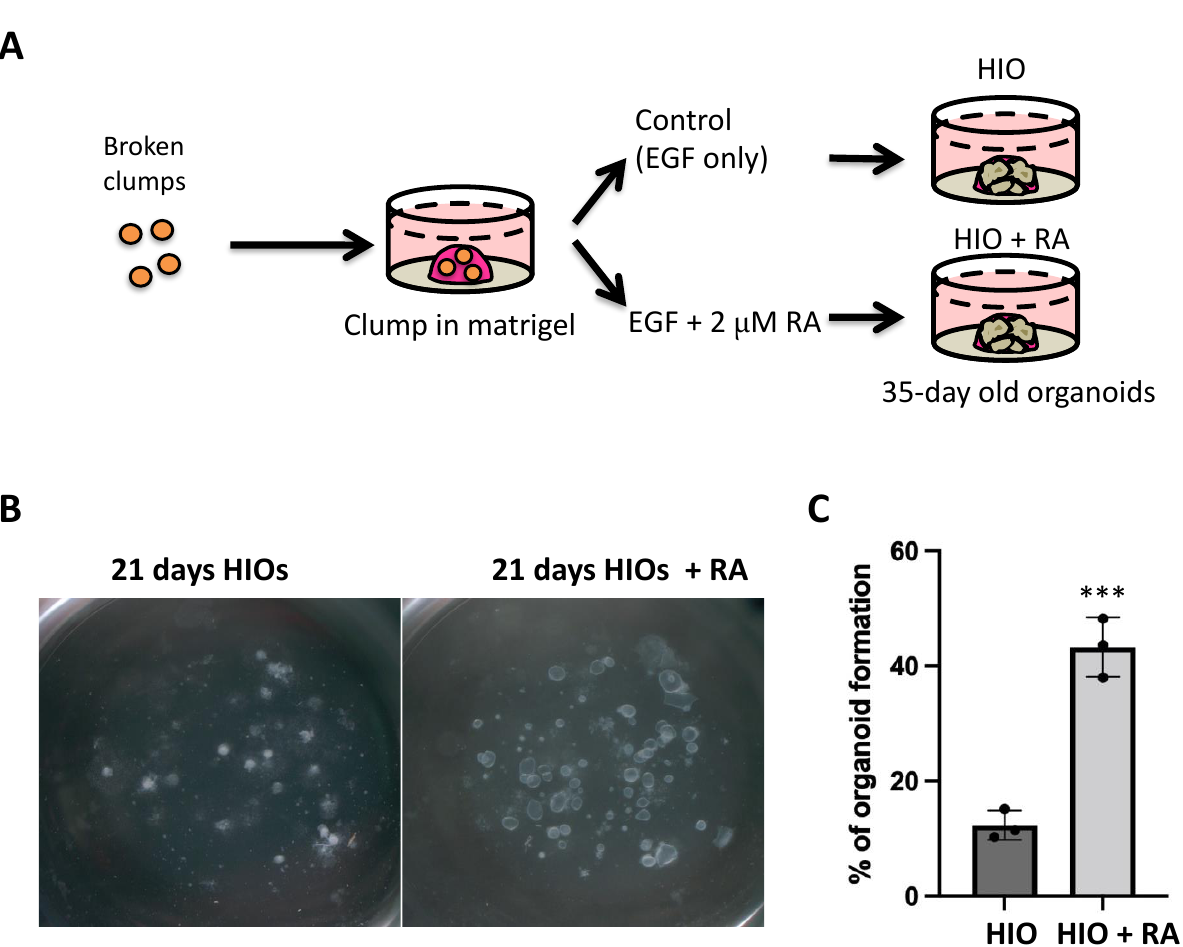
Figure 2. Retinoic acid treatment improves organoid generation. ( A ) Schematic of retinoic acid treatment experiments utilizing HIOs. ( B ) Stereomicroscope images of 21-day-old organoids from the treatment groups. ( C ) Quantification of organoid-forming efficiency. Individual point represents quantification from a single biological replicate ( n = 3 per group). *** denotes p < 0.001 based on t